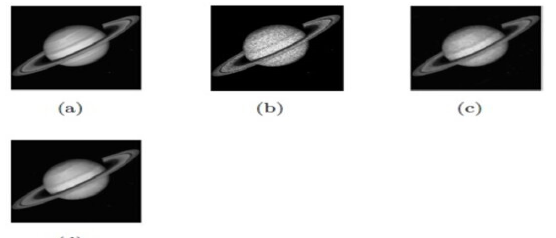
Fig. 4: Restoration Performance by two different methods on Synimage 1: (a) True Image (b) Noisy Image with Speckle